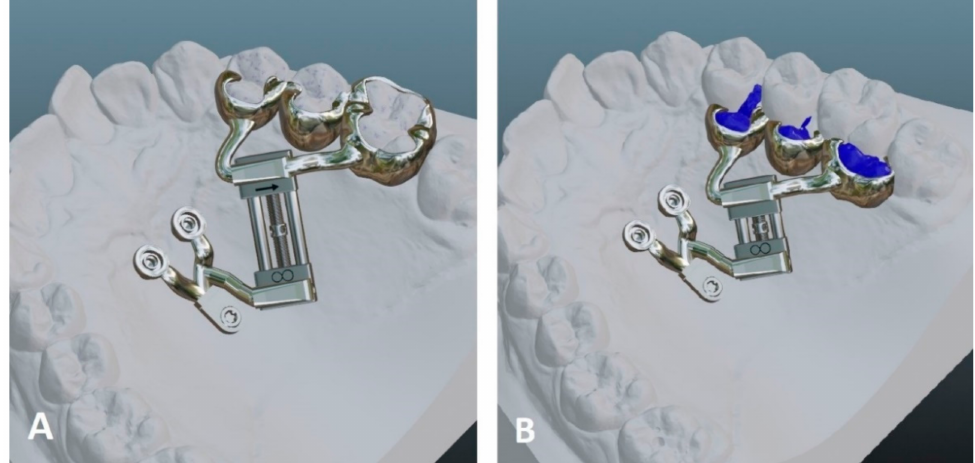
Figure 3. ( A ) Customized active element connected to implants and teeth. ( B ) Simulated activation with estimated movement of teeth (blue) (software: Blender, Blender